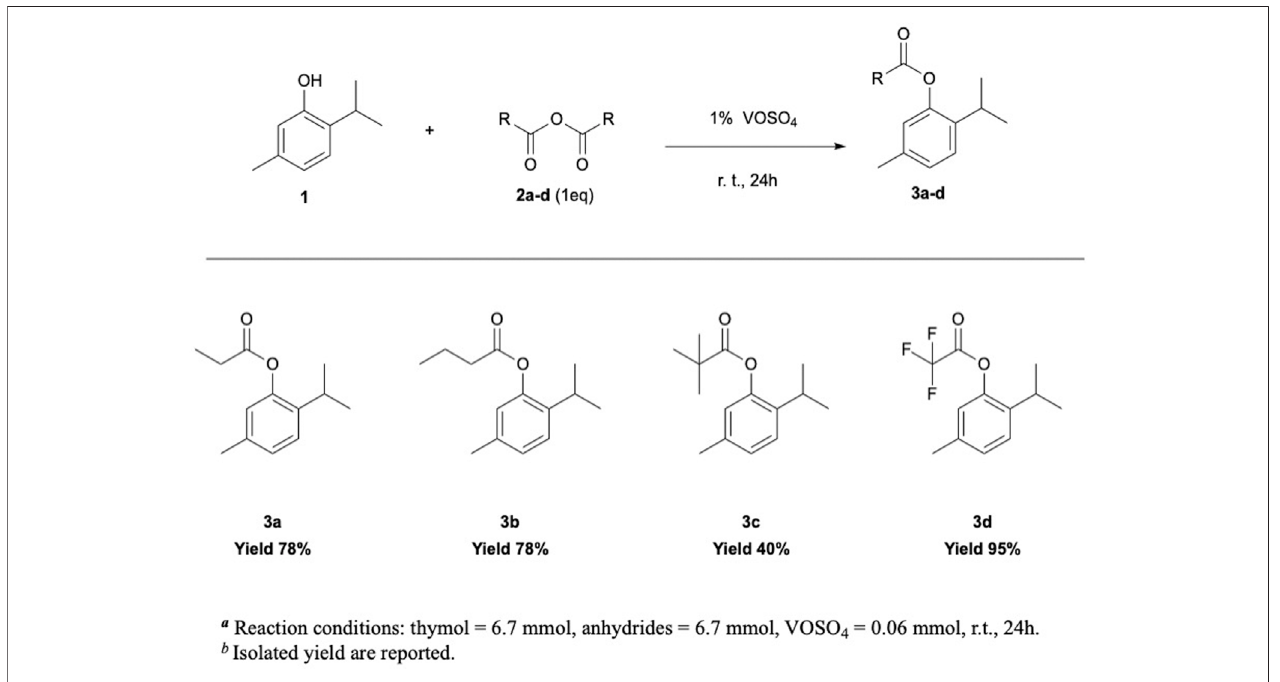
FIGURE 1 | Thymol acetylation reaction using different anhydrides as the acetylating agent.